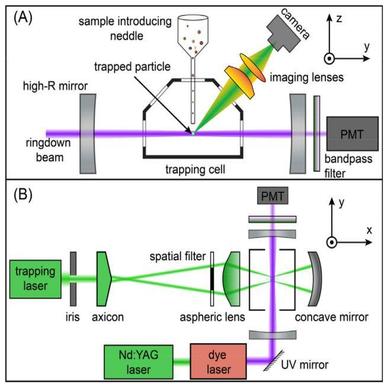
The experimental setup of the optical-trapping cavity-ringdown spectroscopy system. (A) A side view of the cavity-ringdown-spectroscopy system; (B) A top view of the confocal-hollow-beam optical trap integrated with the ringdown system. The trapping beam was along the x-axis, the ringdown beam was along the y-axis, and the z-axis was aligned vertically up.